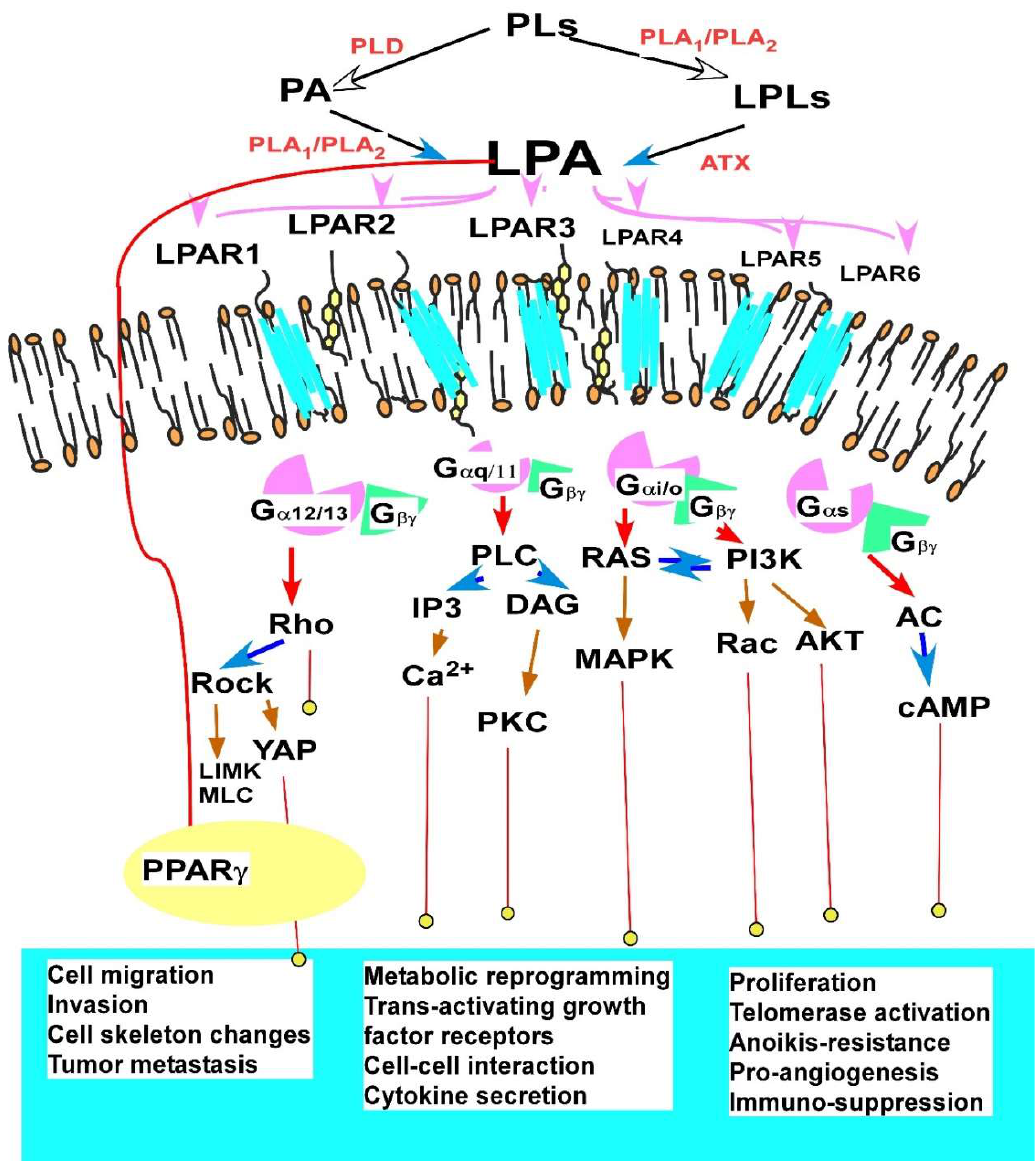
Figure 2. Diagram illustration of LPA receptors, signaling pathways and functions shown in EOC. LPA stimulates almost every aspect of tumor promoting activities [24,25,29–31,44,45,70,77–94]. This figure illuminates updated information related to LPA receptors (LPAR 1 to LPAR 6 , and PPARγ), signaling pathways, and functions shown in EOC, modified from a previous review article by Yung et al. [94]. In particular, the nuclear receptor for LPA, PPARγ is included. While Gα12/13, Gαq, and Gαi mediate tumor promoting activities in most cases, Gαs is likely to be a negative regulator counter-reacting Gαi actions. Abbreviations: autotaxin (ATX); LIM kinase (LIMK); lysophospholipids (LPLs); myosin light chain (MLC) phosphatidic acid (PA); phospholipids (PLs); phospholipase D (PLD); phospholipase A 1 (PLA 1 ); and phospholipase A 2 (PLA 2 ).